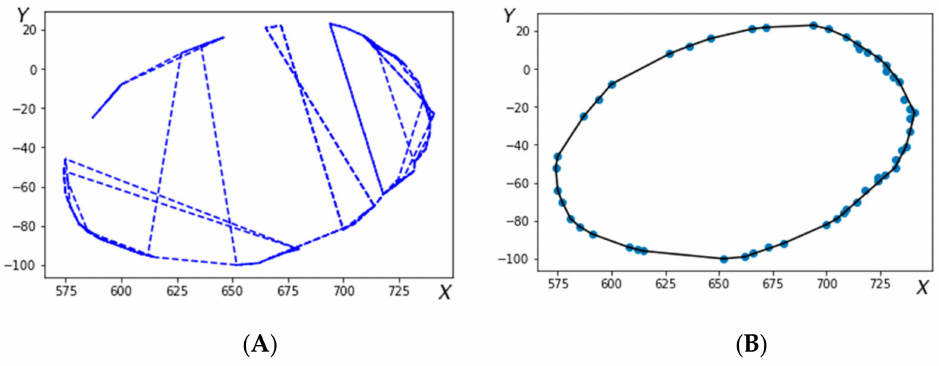
Figure 2. Cross-sections: ( A ) points before arrangement, ( B ) points after